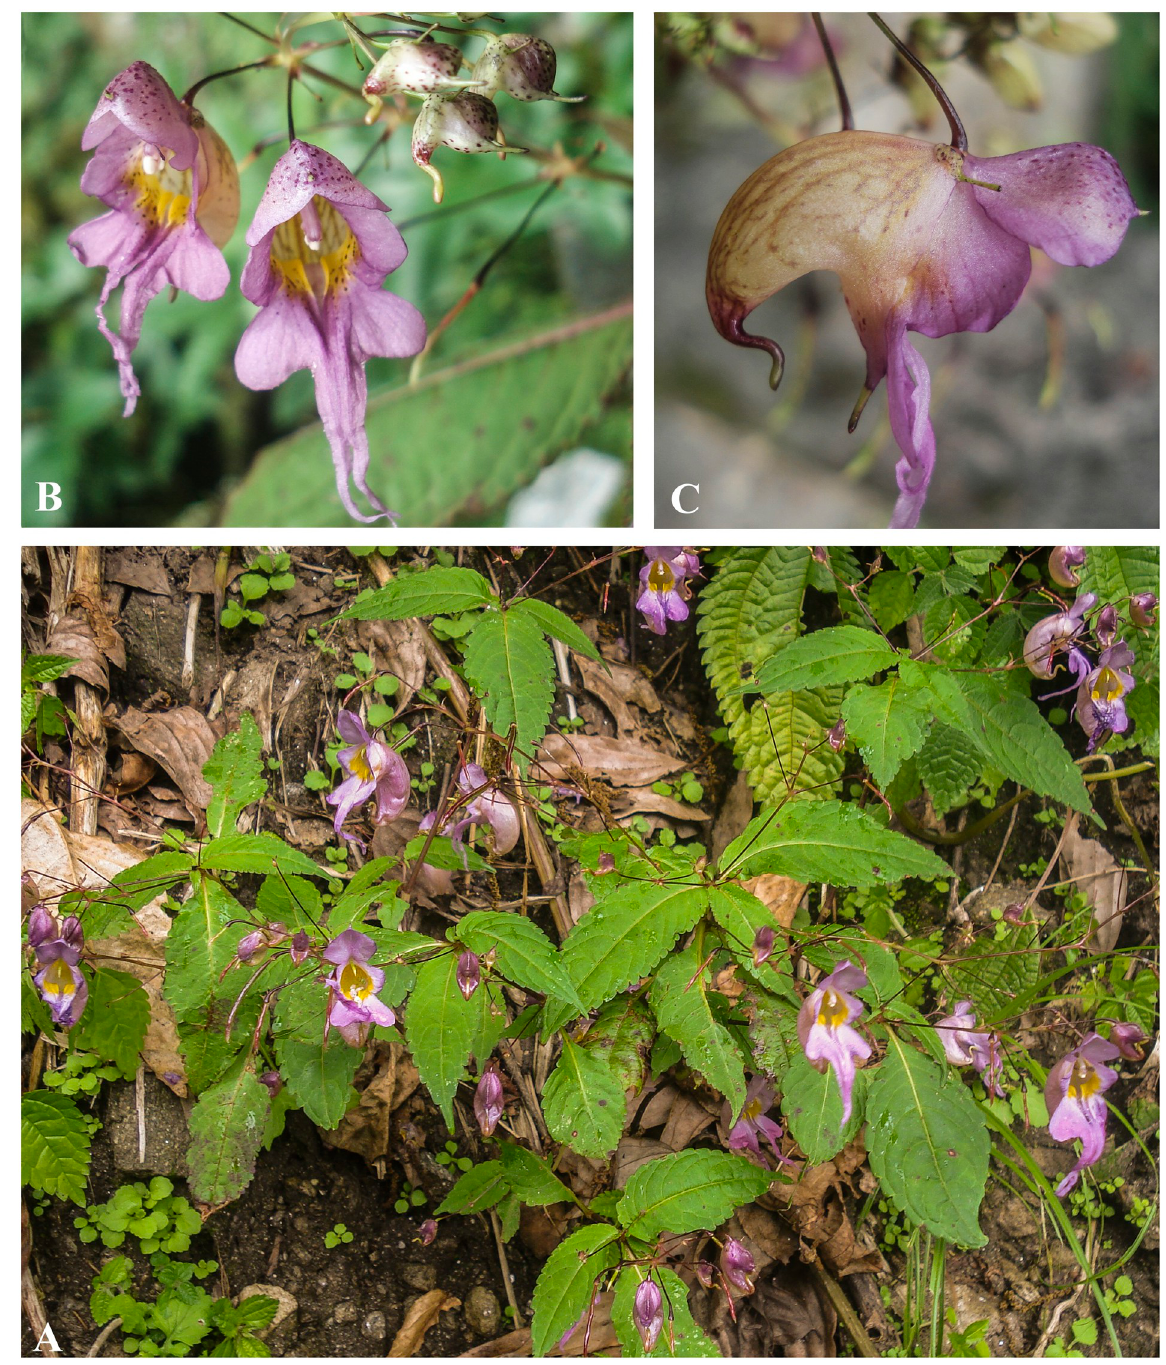
Fig 6. Impatiens bicornuta A. Flowering plant; B. Front view of flower; C. Flower (side view). Photographs by Bhakta Bahadur Raskoti.